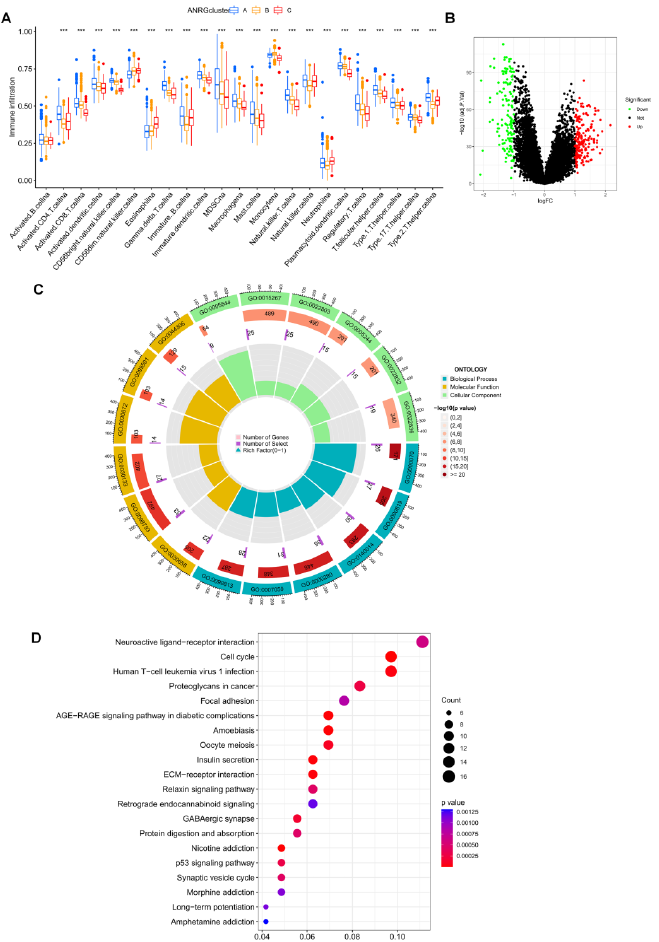
Figure 4. Differences in immune infiltration patterns and enrichment analysis of DEGs in the three subtype groups. ( A ) Immune infiltration patterns of three subtype groups were obtained using ssGSEA. ( B ) Volcano plot of up-and down-regulated DEGs in clusters A and B. ( C ) GO analysis circle diagram of DEGs. ( D ) Bubble diagram of KEGG enrichment analysis of DEGs.* p < 0.05, ** p < 0.01, *** p <